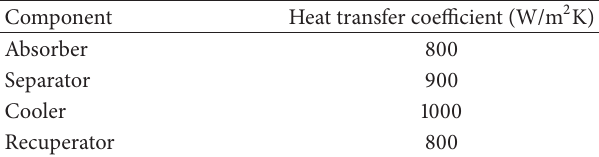
Table 3: Heat transfer coefficients for heat exchangers